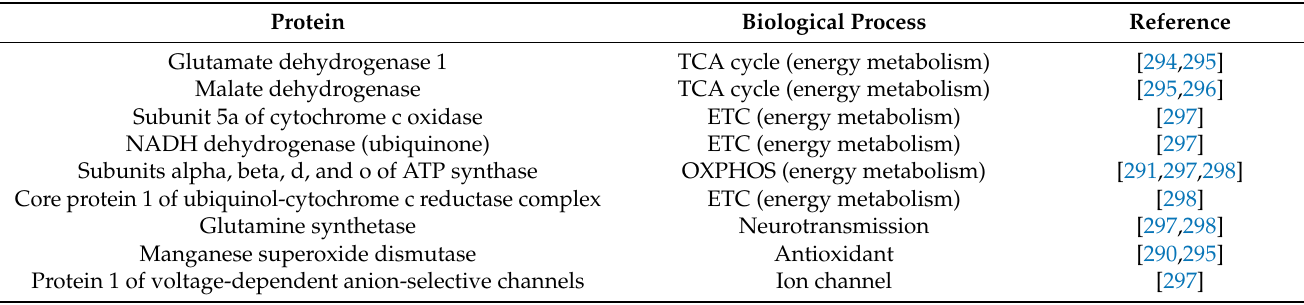
Table 1. The modified mitochondrial proteins described in AD and their involvement in cellular processes (adapted from Jov é et al.